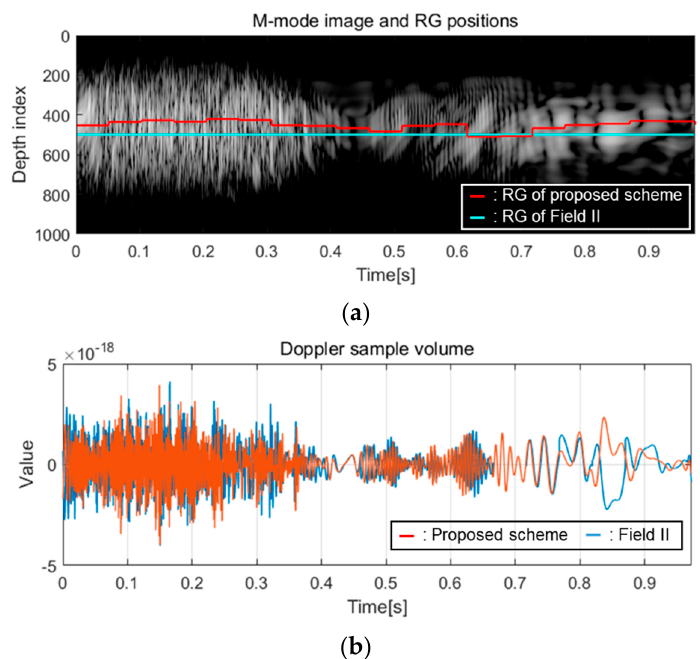
Figure 11. Behavioral simulation results of ( a ) M-mode image along with RG positions and ( b ) Dop- pler sample volumes; RG: range gate. ( b ) Doppler sample volumes; RG: range